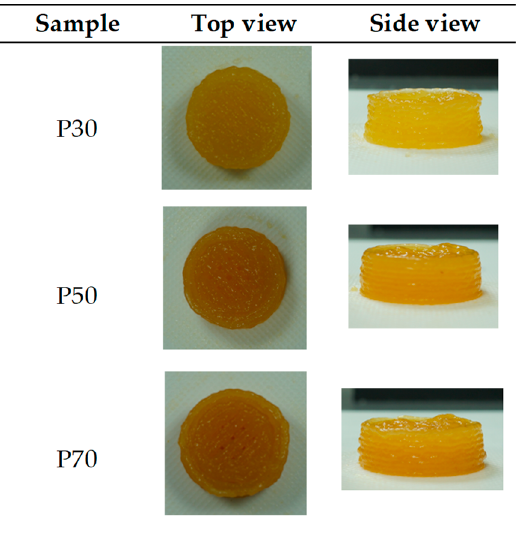
Figure 4. 3D printed samples top and frontal view just after printing. (P30: Printed sample 30% pulp; P50: Printed sample 50% pulp; P70: Printed sample 70% pulp).